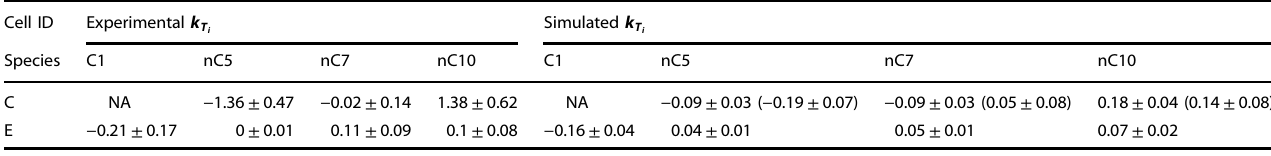
Table 3. Measured and simulated thermal diffusion ratio of the various species in the two exploitable SCCO-SJ-10 cells. Values in parenthesis correspond to the results of the AUA molecular model